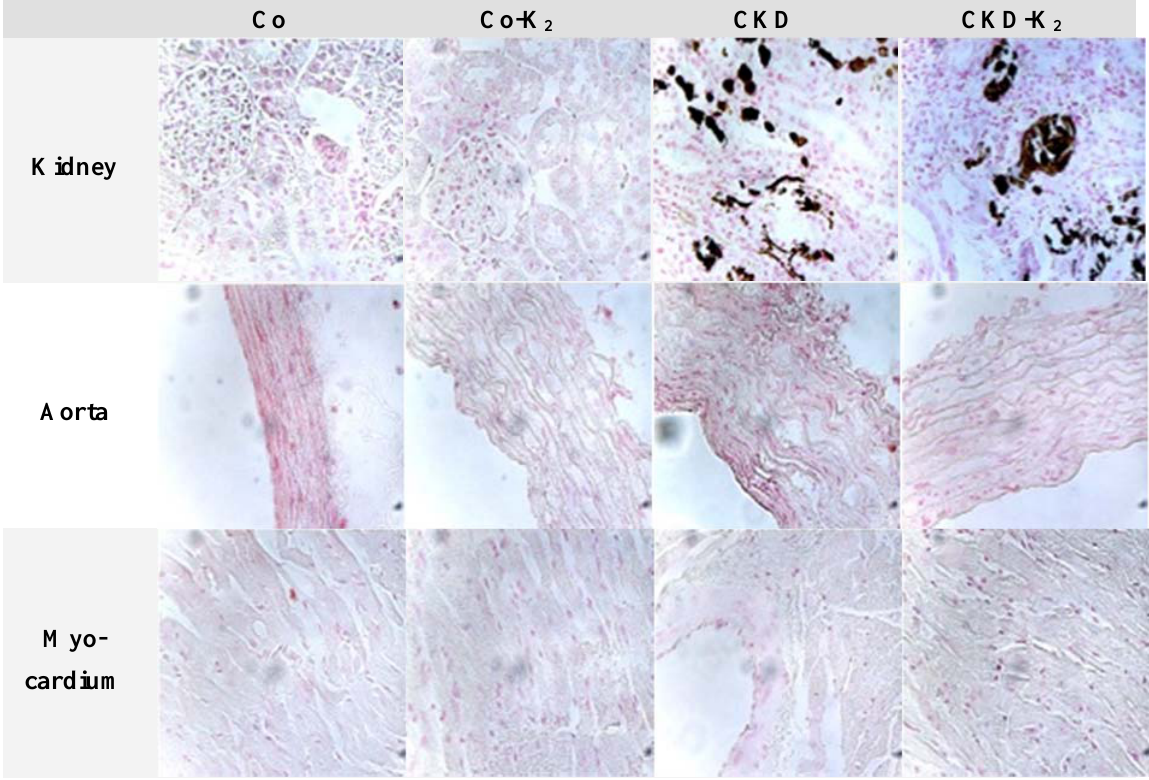
Figure 6. Representative sections of von Kossa stained tissue samples. Microscopically visible von Kossa positive staining was only detected in kidney tissue samples of CKD and CDK-K 2 animals. Magnification 40×; Counterstain: nuclear fast red; Co = control group; Co-K 2 = MK-7 supplemented control group; CKD = 5/6 nephrectomized group; CKD-K 2 = MK-7 supplemented 5/6 nephrectomized group.